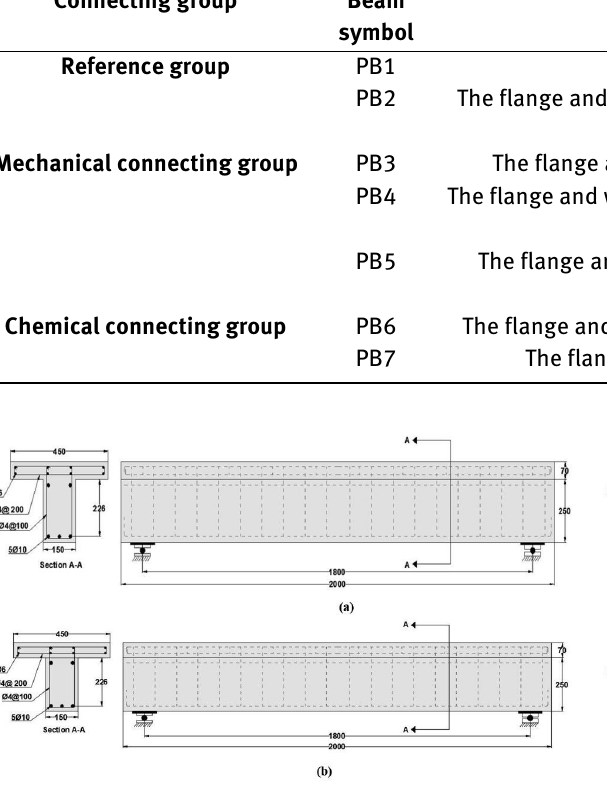
Figure 1: Details of reference specimens (a) PB1; (b) PB2